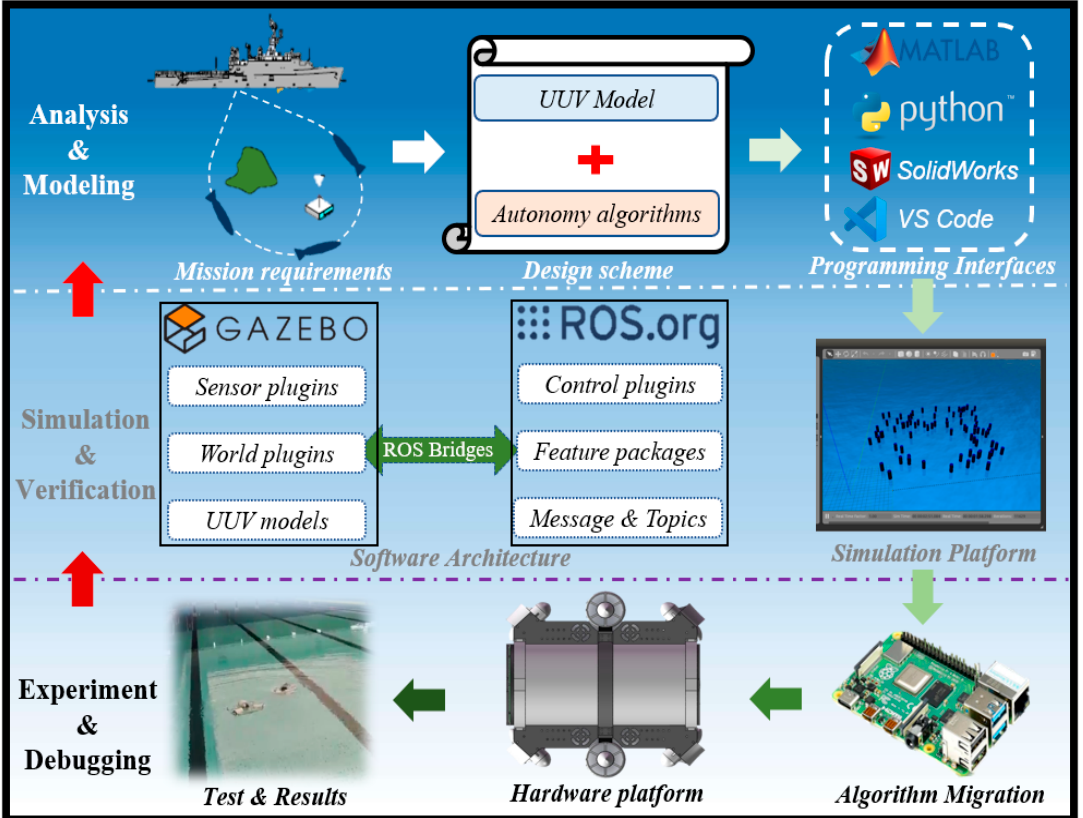
Figure 1. Illustration of the self-feedback development framework.